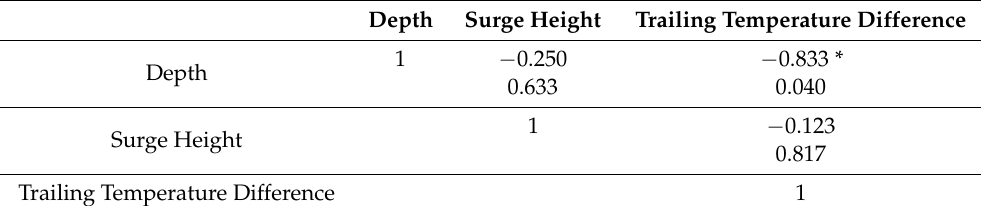
Table 8. Correlation analysis. Depth Surge Height Trailing Temperature